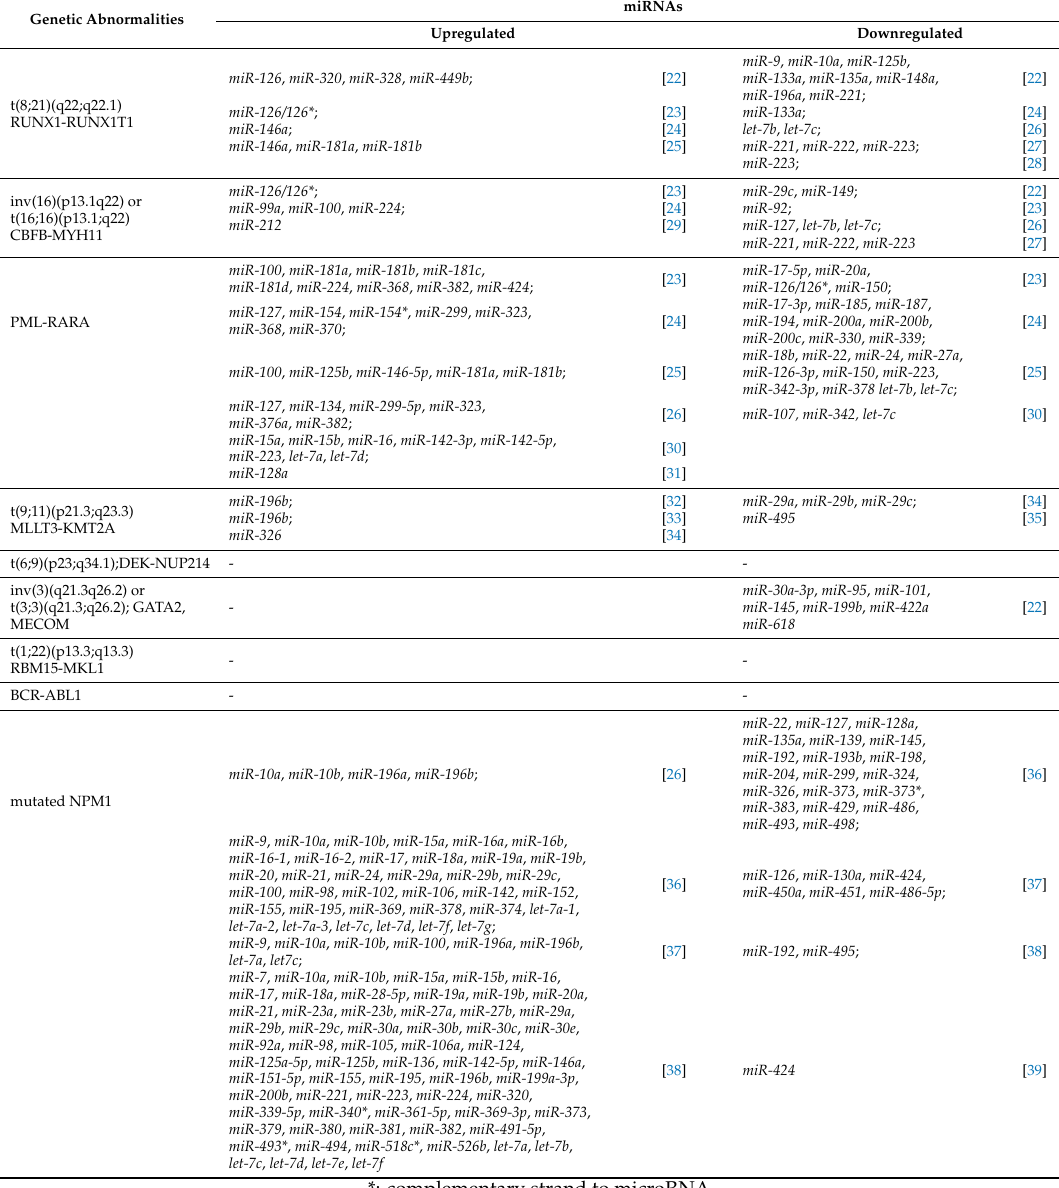
MicroRNA (miRNA) expression in acute myeloid leukemias (AML) with recurrent genetic abnormalities.